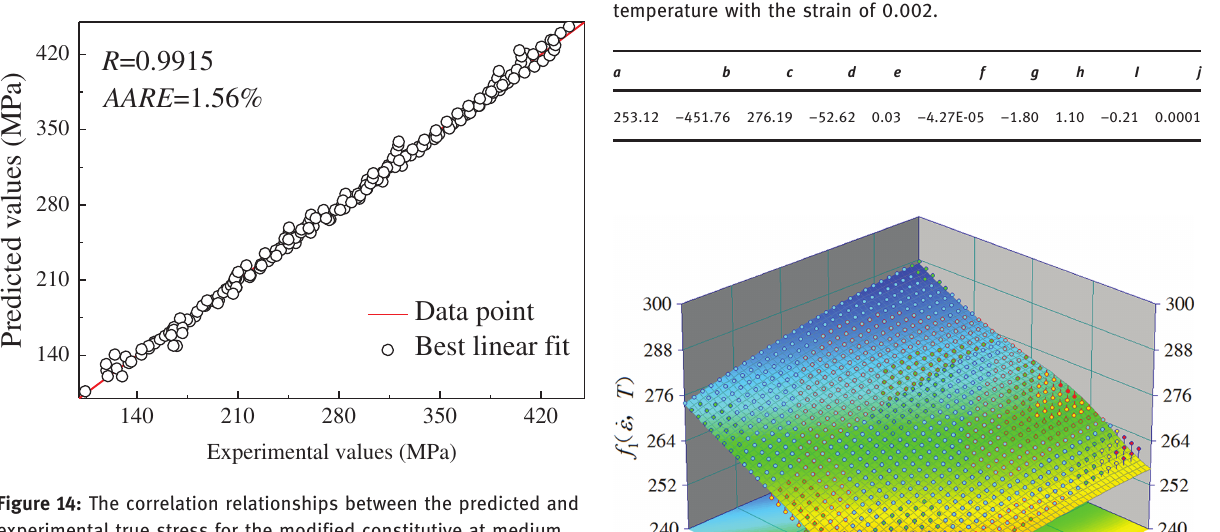
Figure 14: The correlation relationships between the predicted and experimental true stress for the modified constitutive at medium temperature region.